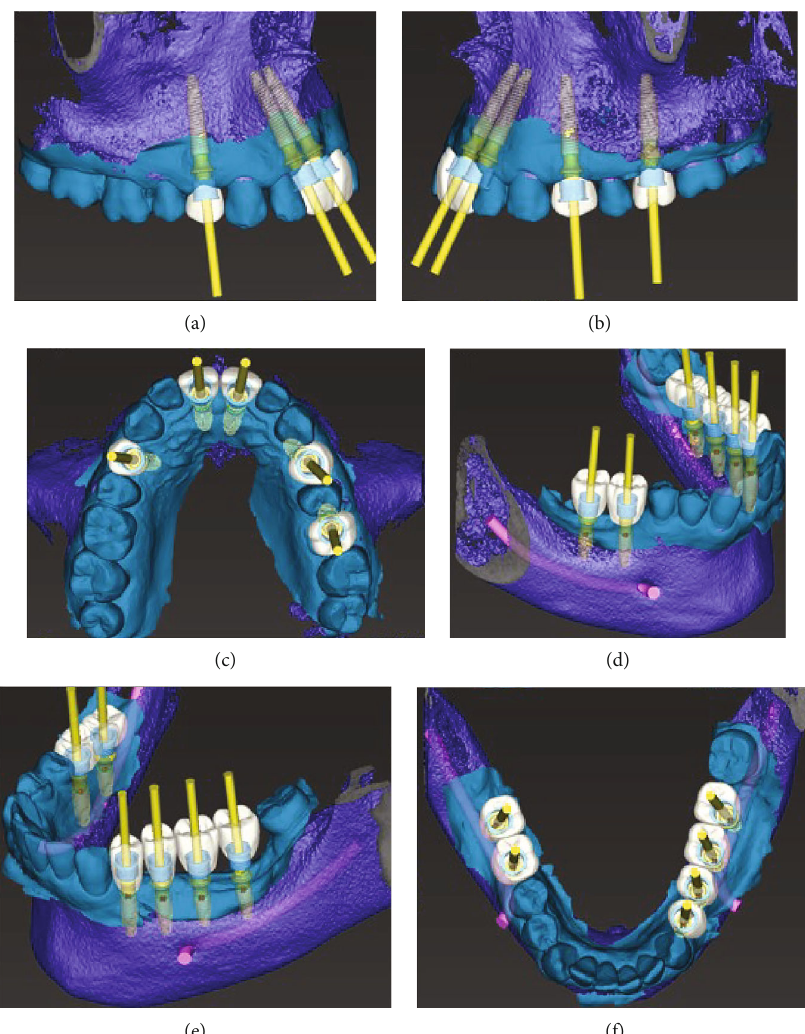
Figure 2: Virtual planning of maxillary (a) – (c) and mandibular (d) – (f) implants position considering the planned prosthesis rehabilitation.